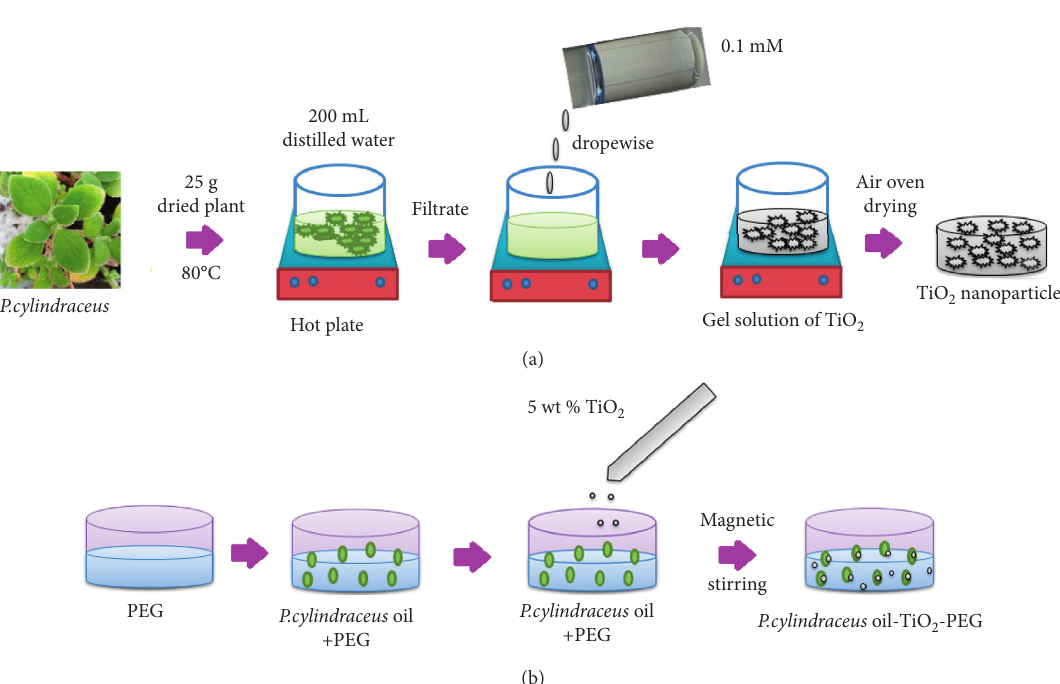
Scheme 1: Schematic demonstration of (a) TiO 2 nanoparticles’ synthesis using the P. cylindraceus aqueous extract and (b) P. cylindraceus oil-TiO 2 -PEG bionanocomposite